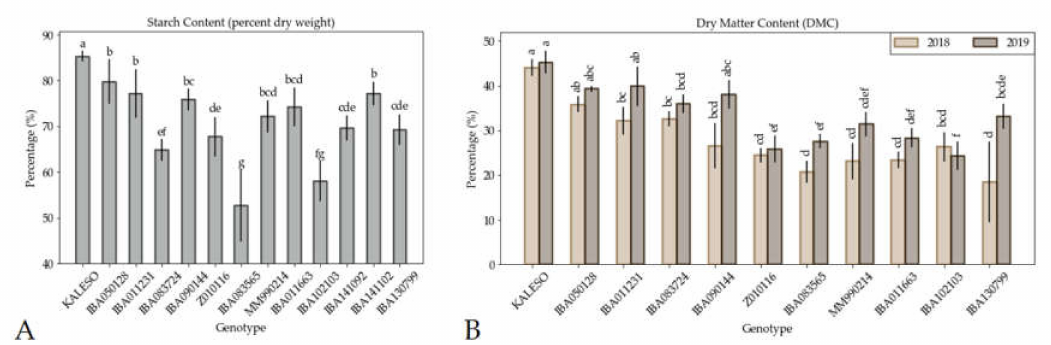
Figure 2. ( A ) Starch in dried 8-month-old root tissue from 13 cassava genotypes using starch enzymatic assay. ( B ) Dry matter content (DMC, %). Error bars represent the standard deviation of the mean from three biological replicates with three technical repetitions per genotype. Groupings generated from ANOVA and Tukey ad hoc tests are above each